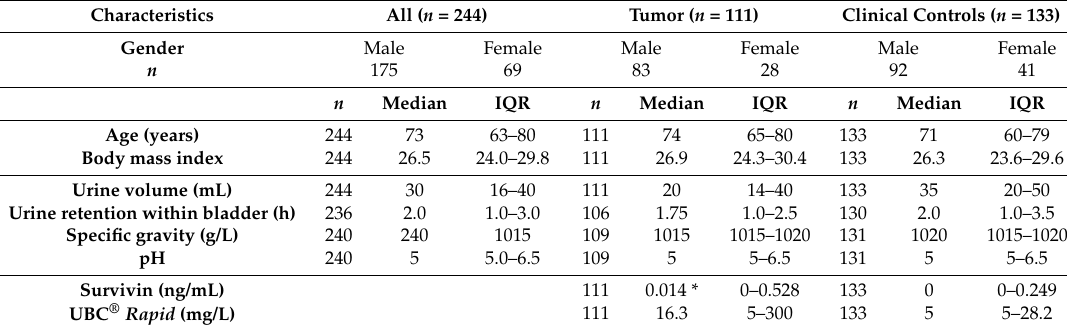
Table 1. Characteristics of the study population and